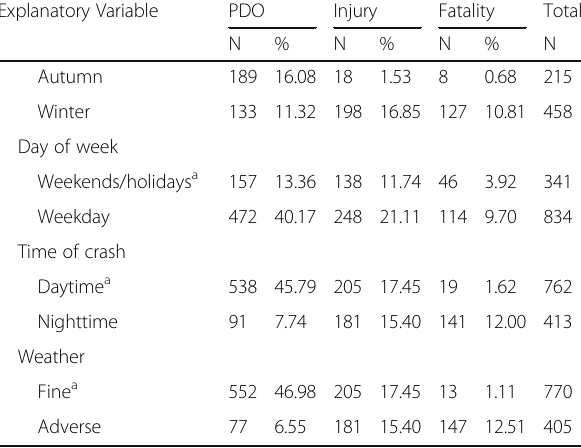
Table 1 Description of explanatory variables